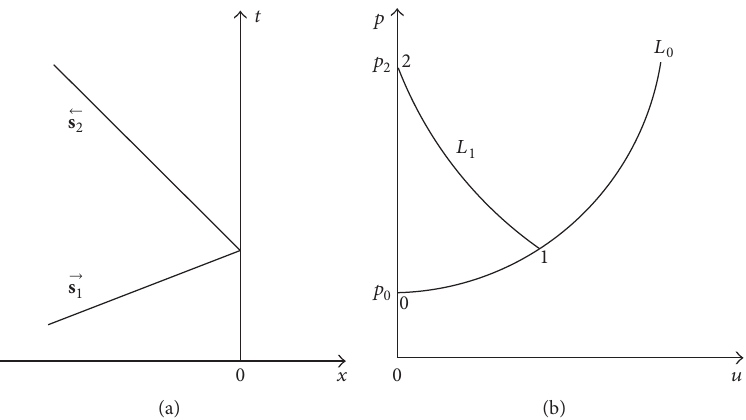
Figure 1: (a) Transfer time- (𝑡 - ) distance ( x ) curve. (b) Pressure- ( p- ) particle velocity ( u ) curve of shock wave.